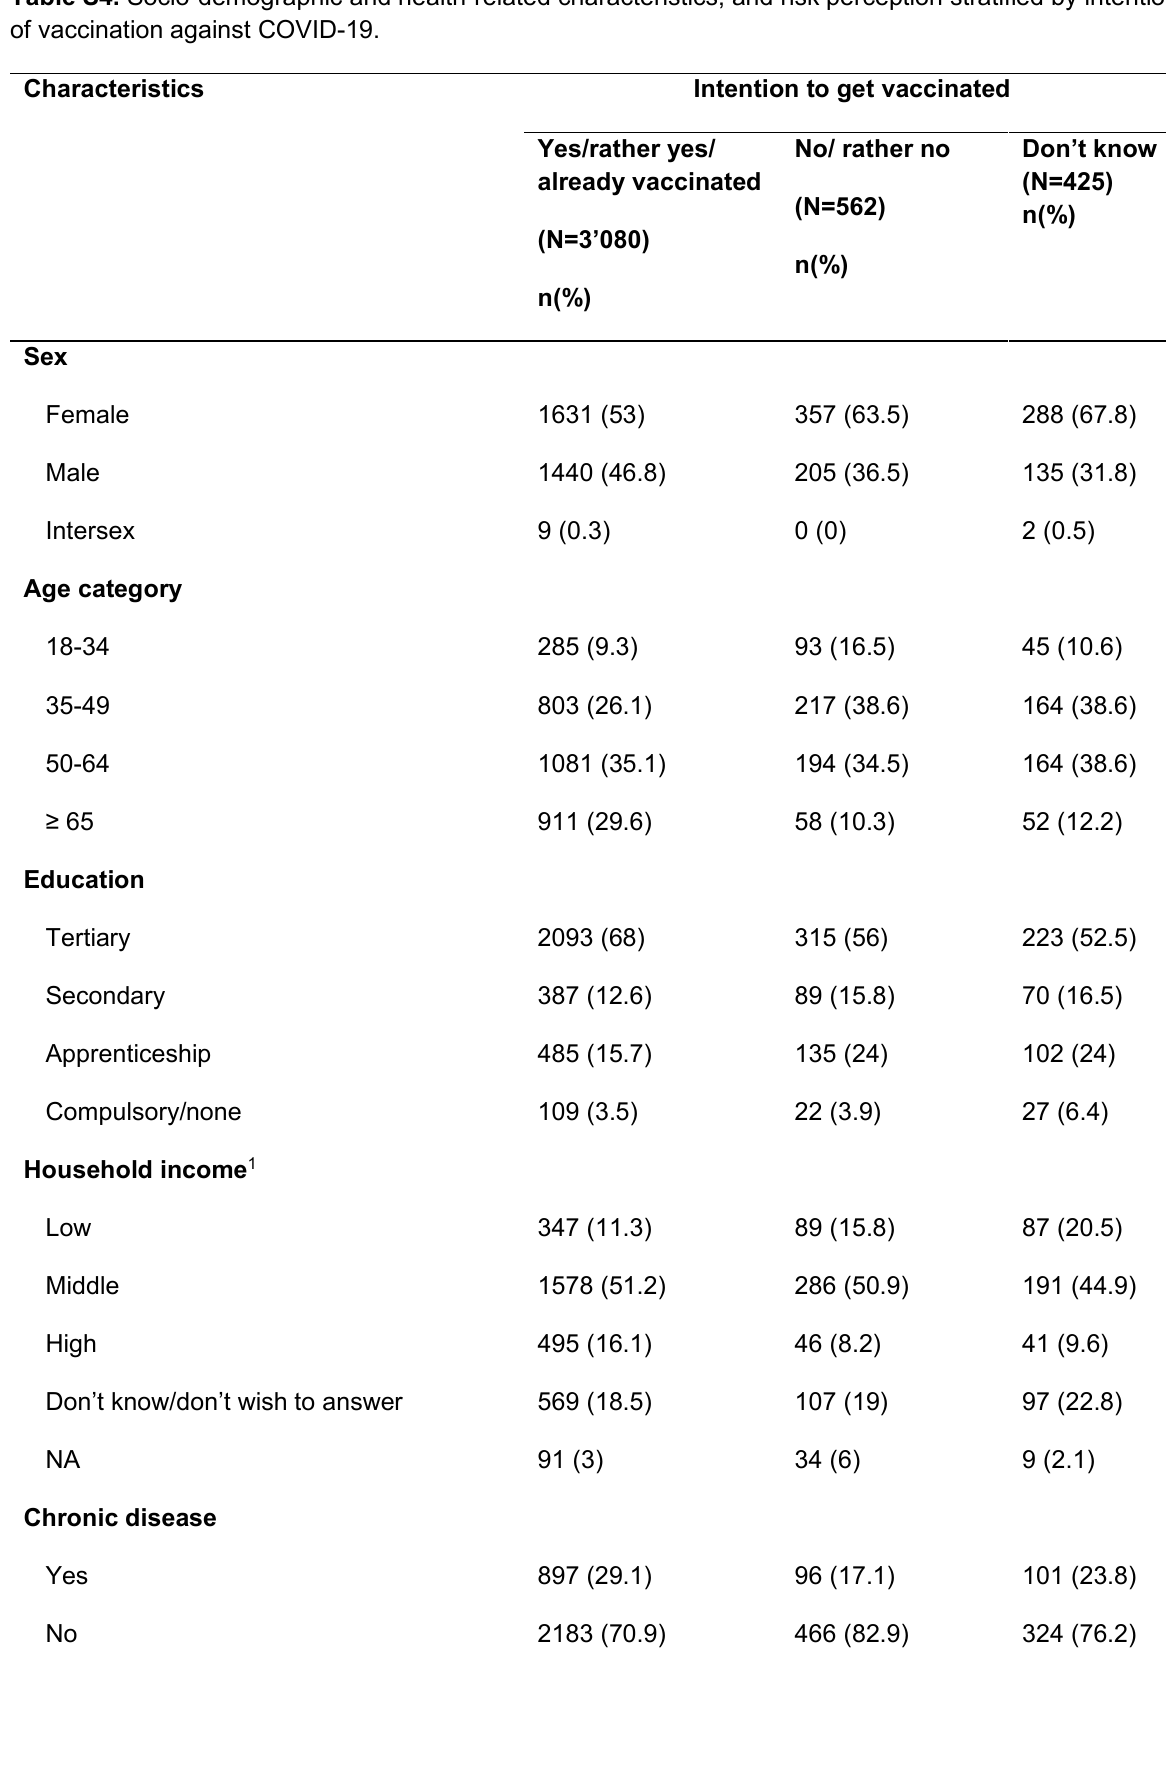
Table S4. Socio-demographic and health-related characteristics, and risk perception stratified by intention of vaccination against